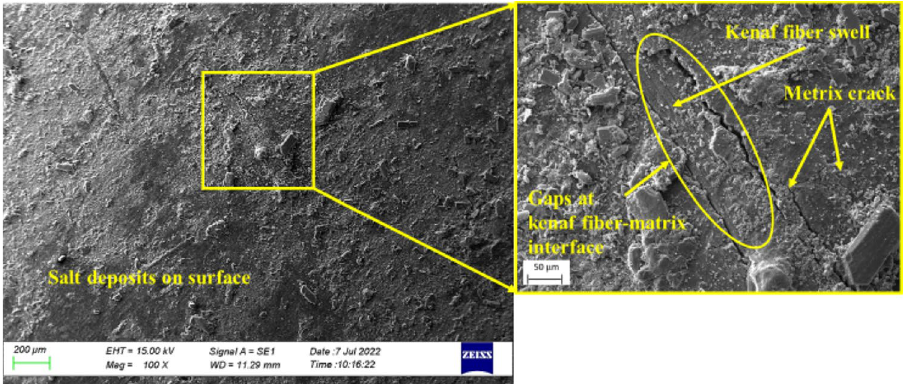
Figure 13. Scanning electron micrographs of the surface of the MCC12 composite post-immersion in seawater.